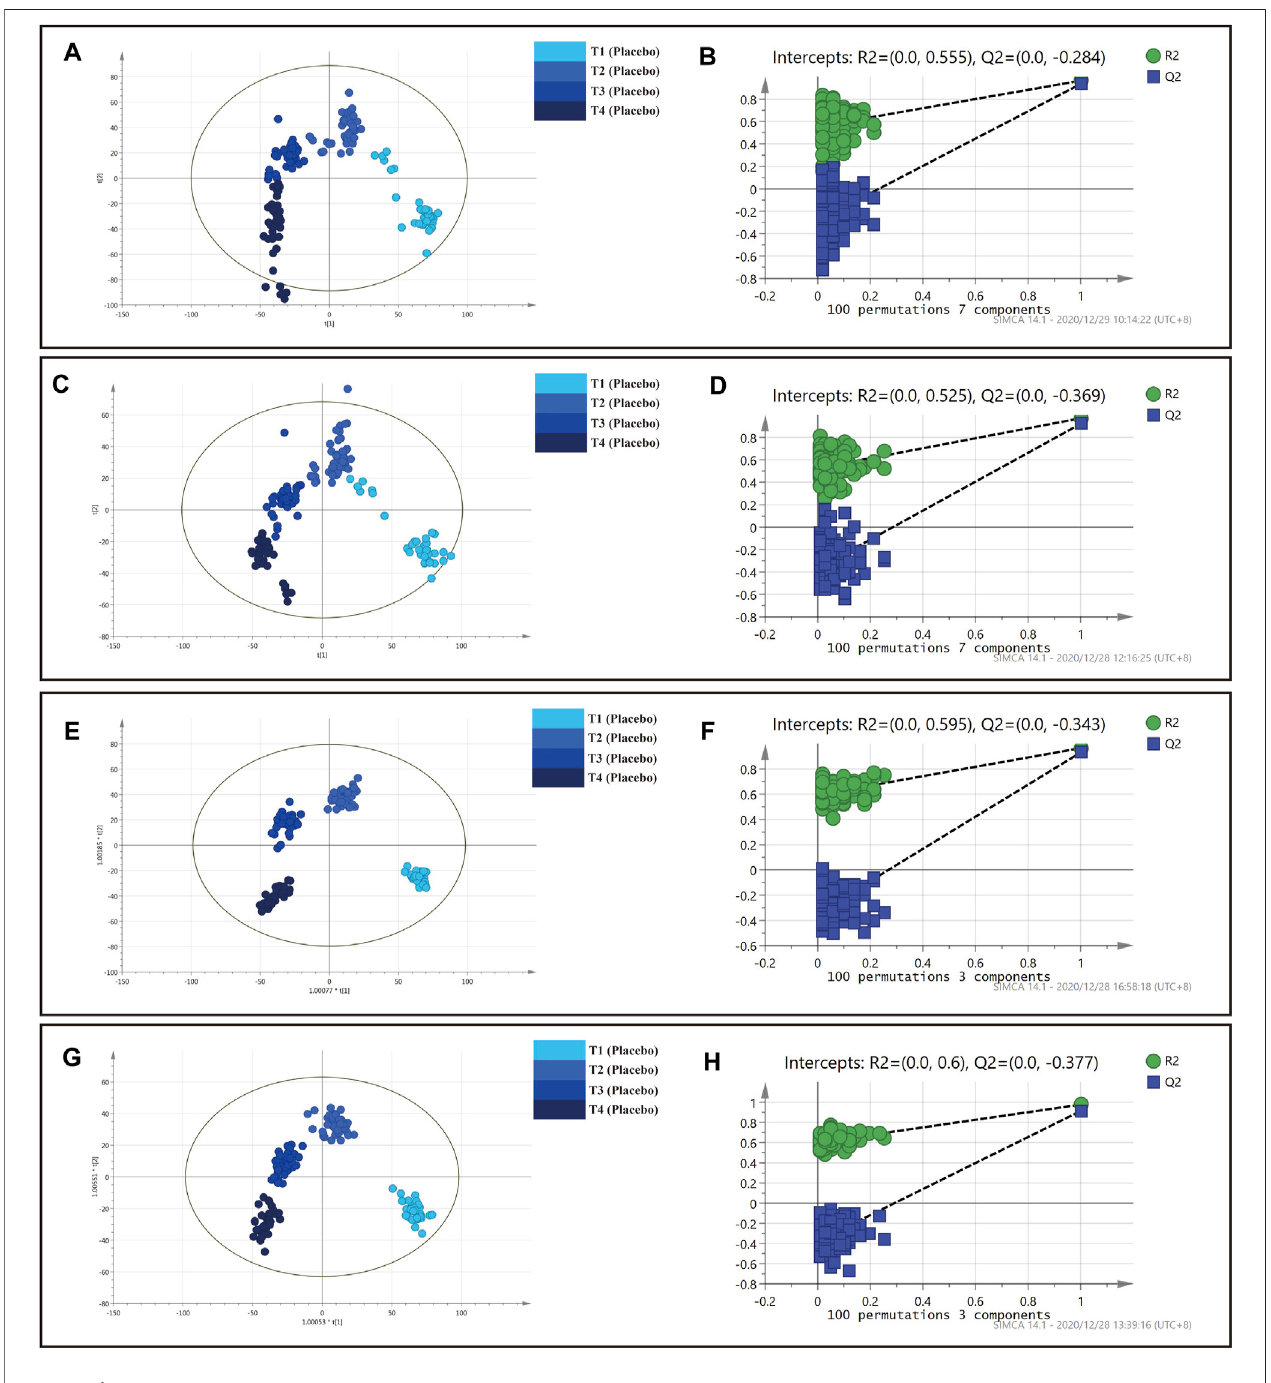
FIGURE4| PLS-DAandOPLS-DAanalysisonplasmasamplesinplacebogroup. (A) PLS-DAanalysisinpositivemode. (B) PermutationtestofPLS-DAanalysisin positive mode. (C) PLS-DA analysis in negative mode. (D) Permutation test of PLS-DA analysis in negative mode. (E) OPLS-DA analysis in positive mode. (F) Permutation test of OPLS-DA analysis in positive mode. (G) OPLS-DA analysis in negative mode. (H) Permutation test of OPLS-DA analysis in negative mode. : T1 (Placebo), : T2 (Placebo), : T3 (Placebo), : T4 (Placebo).